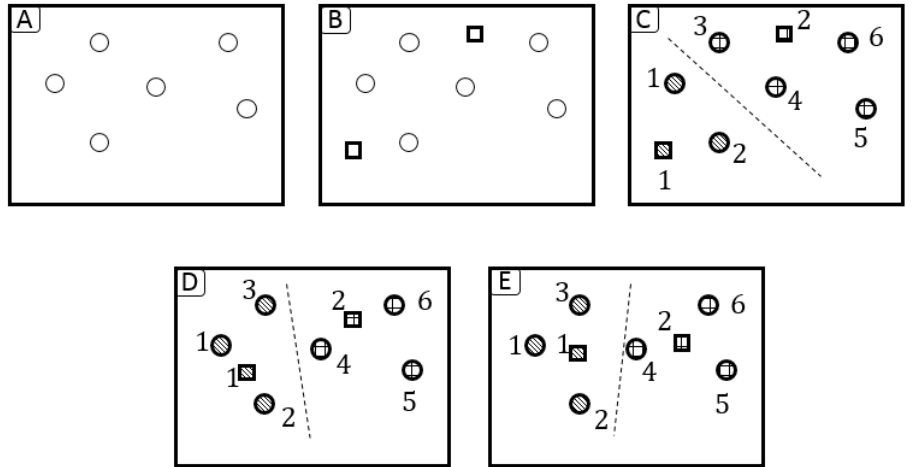
Figure 3. Steps involved in the k-means clustering approach adopted for zoning of the region. ( A ) Nodes in the region for positioning new buildings are identified a priori (i.e., circles); ( B ) centroids of zones to be created are placed randomly in the region (i.e., squares); ( C ) each node in the region is assigned to a centroid based on distance proximity (each node is numbered and assigned to a numbered centroid; matching displayed through the shading in the figure); ( D ) the location of the centroid is recalculated and new nodes are assigned/removed in response; ( E ) the final clusters are created.